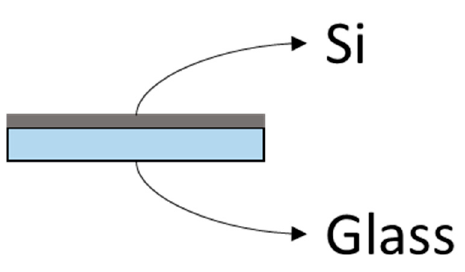
Figure 12. Materials for the proof of concept standard.